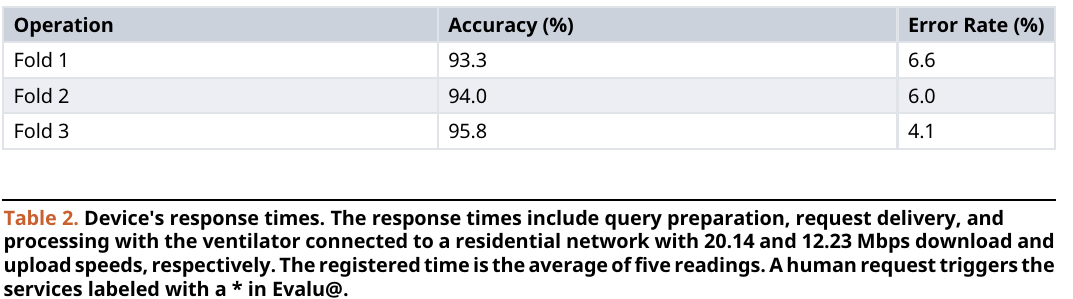
Table 1. Artificial neural network performance.